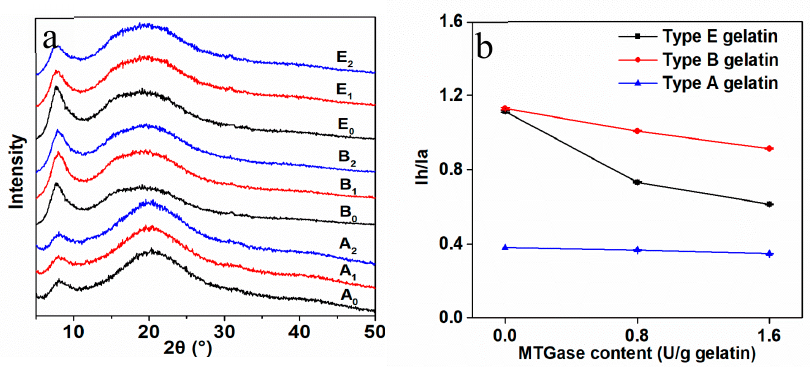
Figure 4. XRD patterns of unmodified and MTGase modified type E gelatin, type B gelatin and type A gelatin films ( a ). Effect of MTGase content on the intensity ratio of triple-helix to amorphous peak (I h /I a ) of unmodified and MTGase modified gelatin films ( b ).